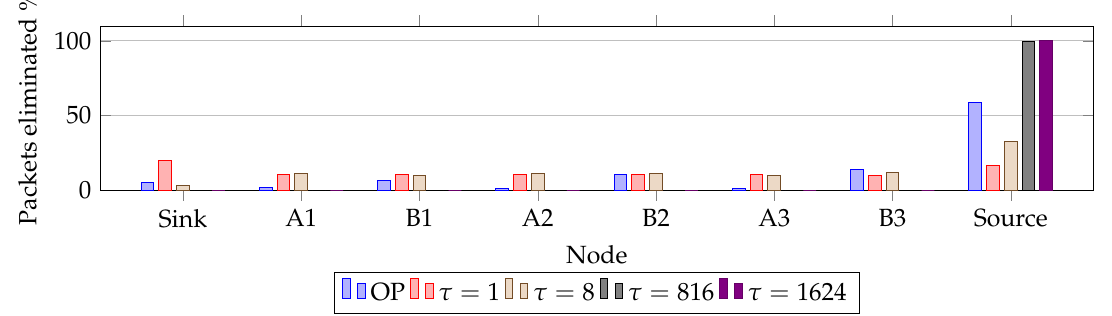
Figure 11. Packet elimination distribution with 80% link quality.